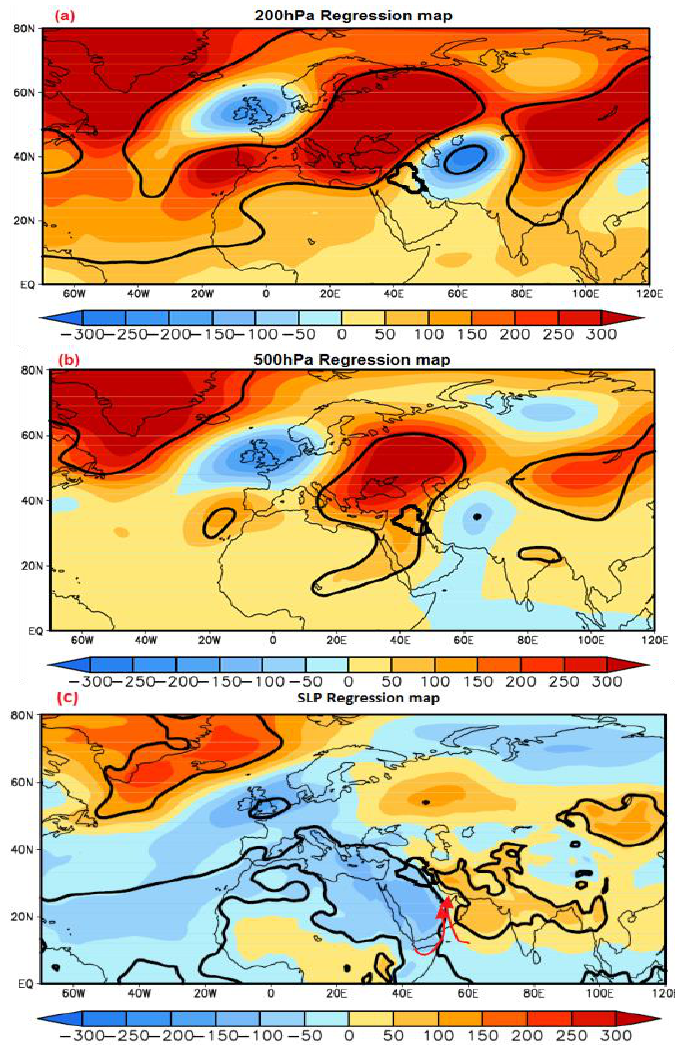
Figure9 Regression maps of summer (a) geopotential height 200hPa, (b) 500hPa and (c) SLP fields on the time series of Indian Ocean SLP associated to the first pair derived through CCA (Fig8b), for the 1979 – 2016 period. The black contour lines in panels (a, b and c) mark the border of Iraq. The thick red arrows in panel (c) are used to explain the air advection. The black contour lines in panels (a, b and c) represent the 95% confidence level of the statistical significance of the regression.